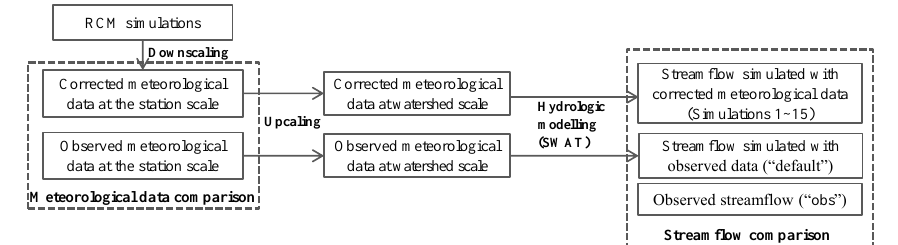
Figure 2. Flow chart of comparison